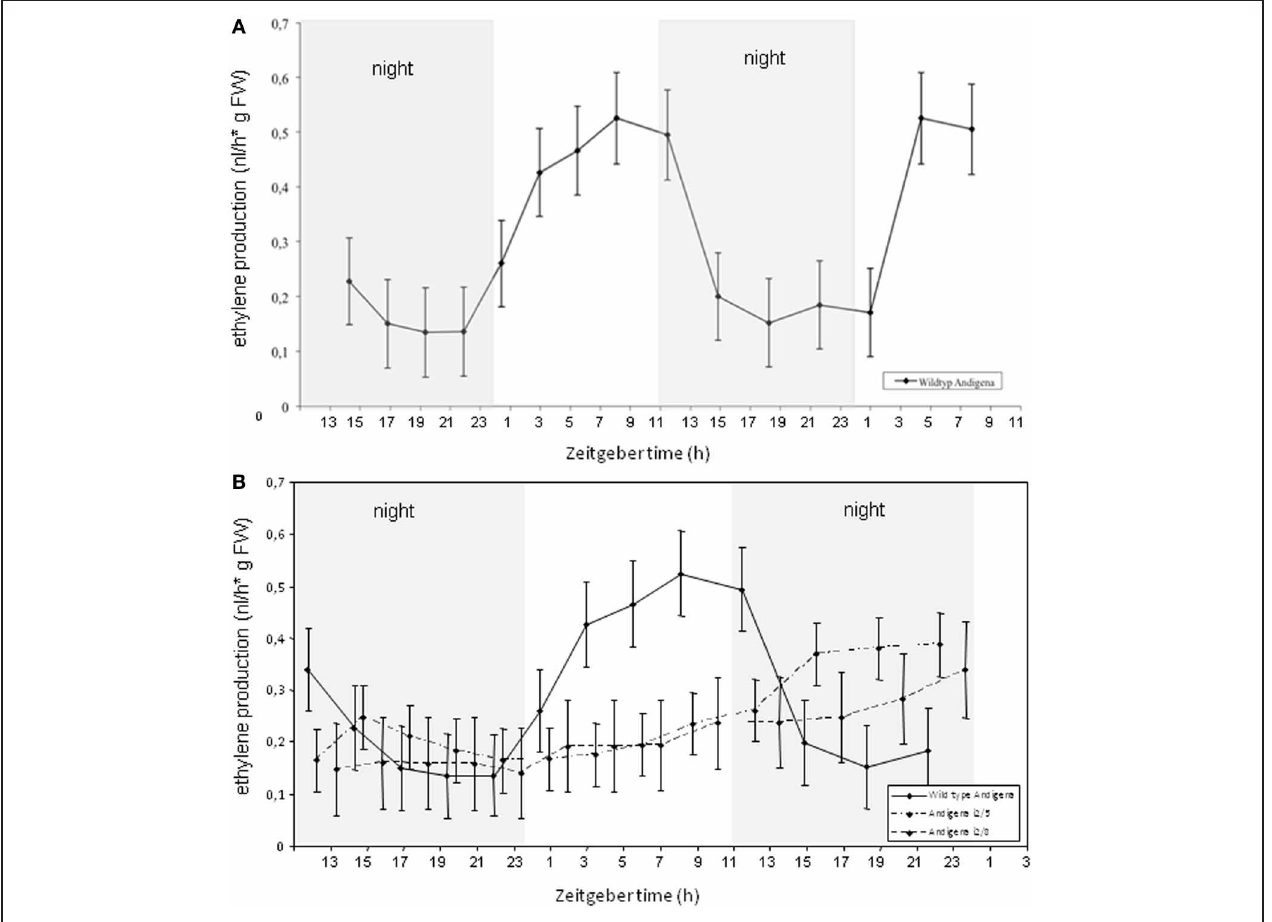
StSUT4-RNAi plants # i2/5 and #i2/8 is significantly lower than in potato wild type plants and does not follow diurnal oscillation pattern. Experiments were repeated twice and a representative example is given. The ethylene production is given in nanoliters per hour per gram fresh weight. Error bars indicate the